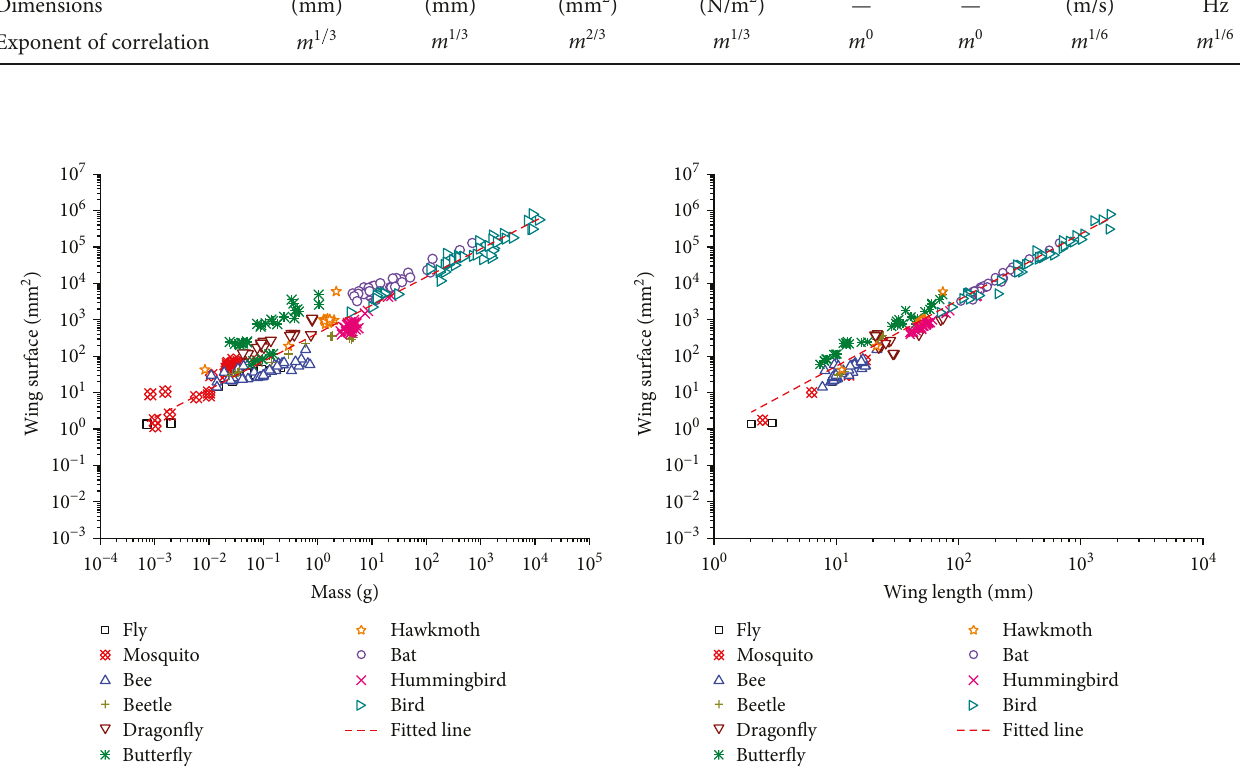
Figure 2: The relation of wing surface vs. mass (left), and wing surface vs. wing length (right).